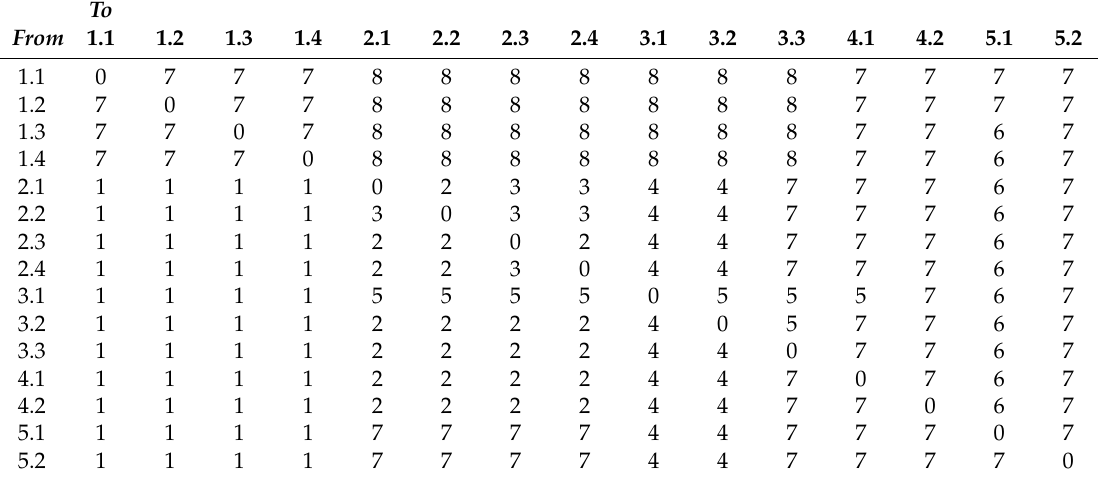
Table 2. Classification of land cover flows (LCF) based on Feranec et al. (2010). To From